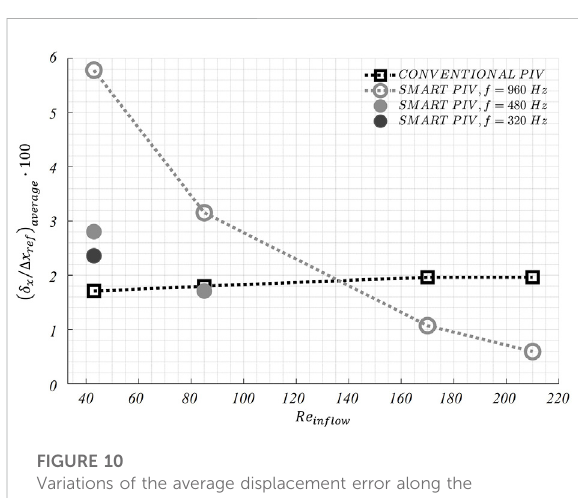
FIGURE 10 Variations of the average displacement error along the streamwise direction ( δ x ) normalized by maximum streamwise particle displacement ( Δ x ref ) as a function of the in fl ow Reynolds number ( Re inflow ) in the healthy LAD phantom. For smart PIV, the normalized average displacement error δ x / Δ x ref is evaluated also by virtually reducing the image acquisition frequency to 480 Hz (for Re inflow = 43, Re inflow = 85) and 320 Hz (for Re inflow =